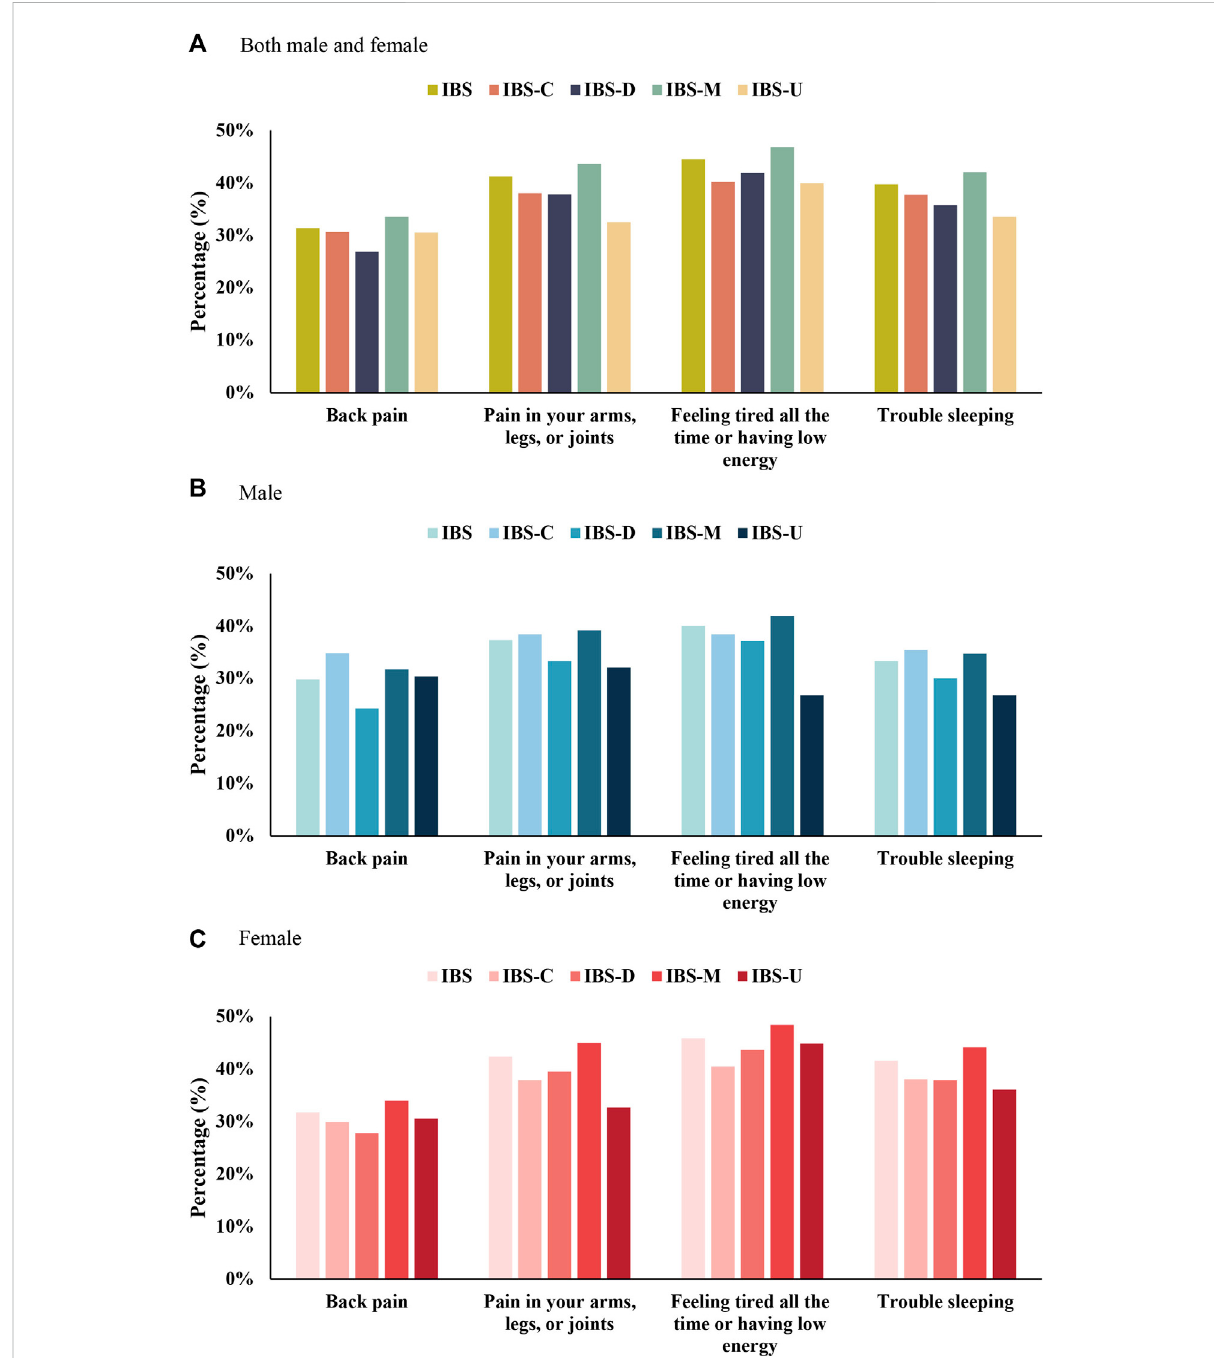
FIGURE 3 Top four extraintestinal somatic symptoms in IBS and its subtypes. (A) Both male and female. (B) Male. (C) Female.